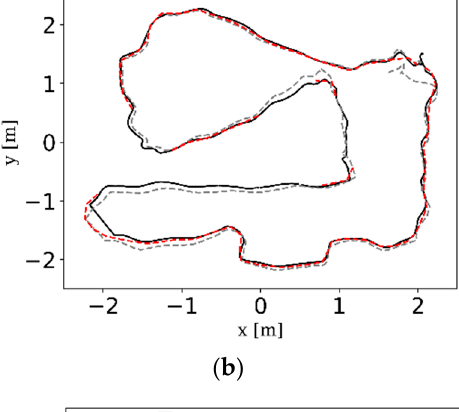
Figure 20. RMSEs and Median ATEs for VINS-MKF, VINS-Mono. ( a ) RMSEs of translational error; ( b ) Median ATEs of translation.